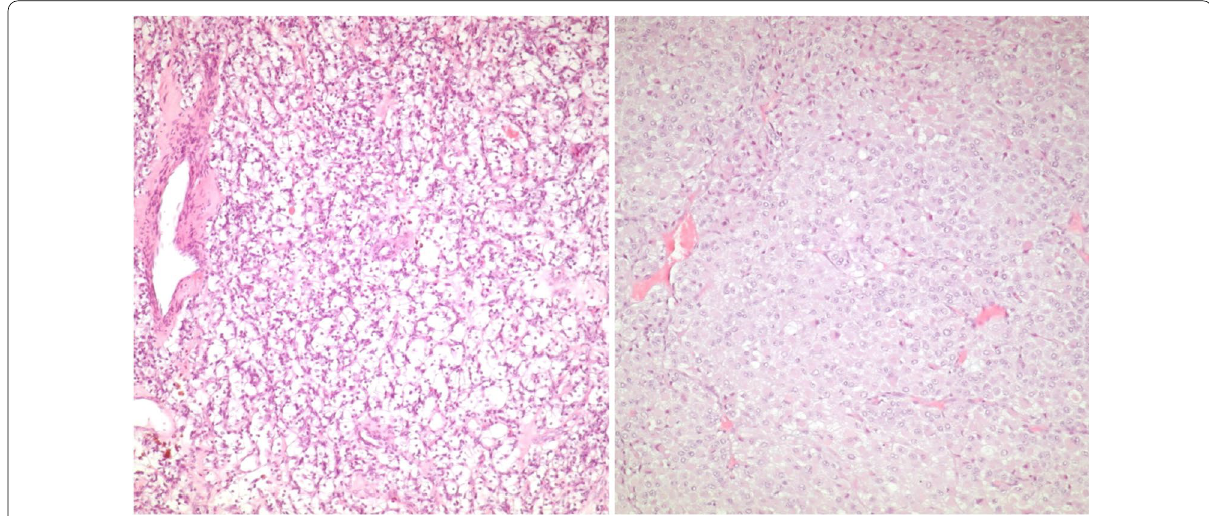
Fig. 3 Histopathology Left: renal cell carcinoma. Right: adrenocortical